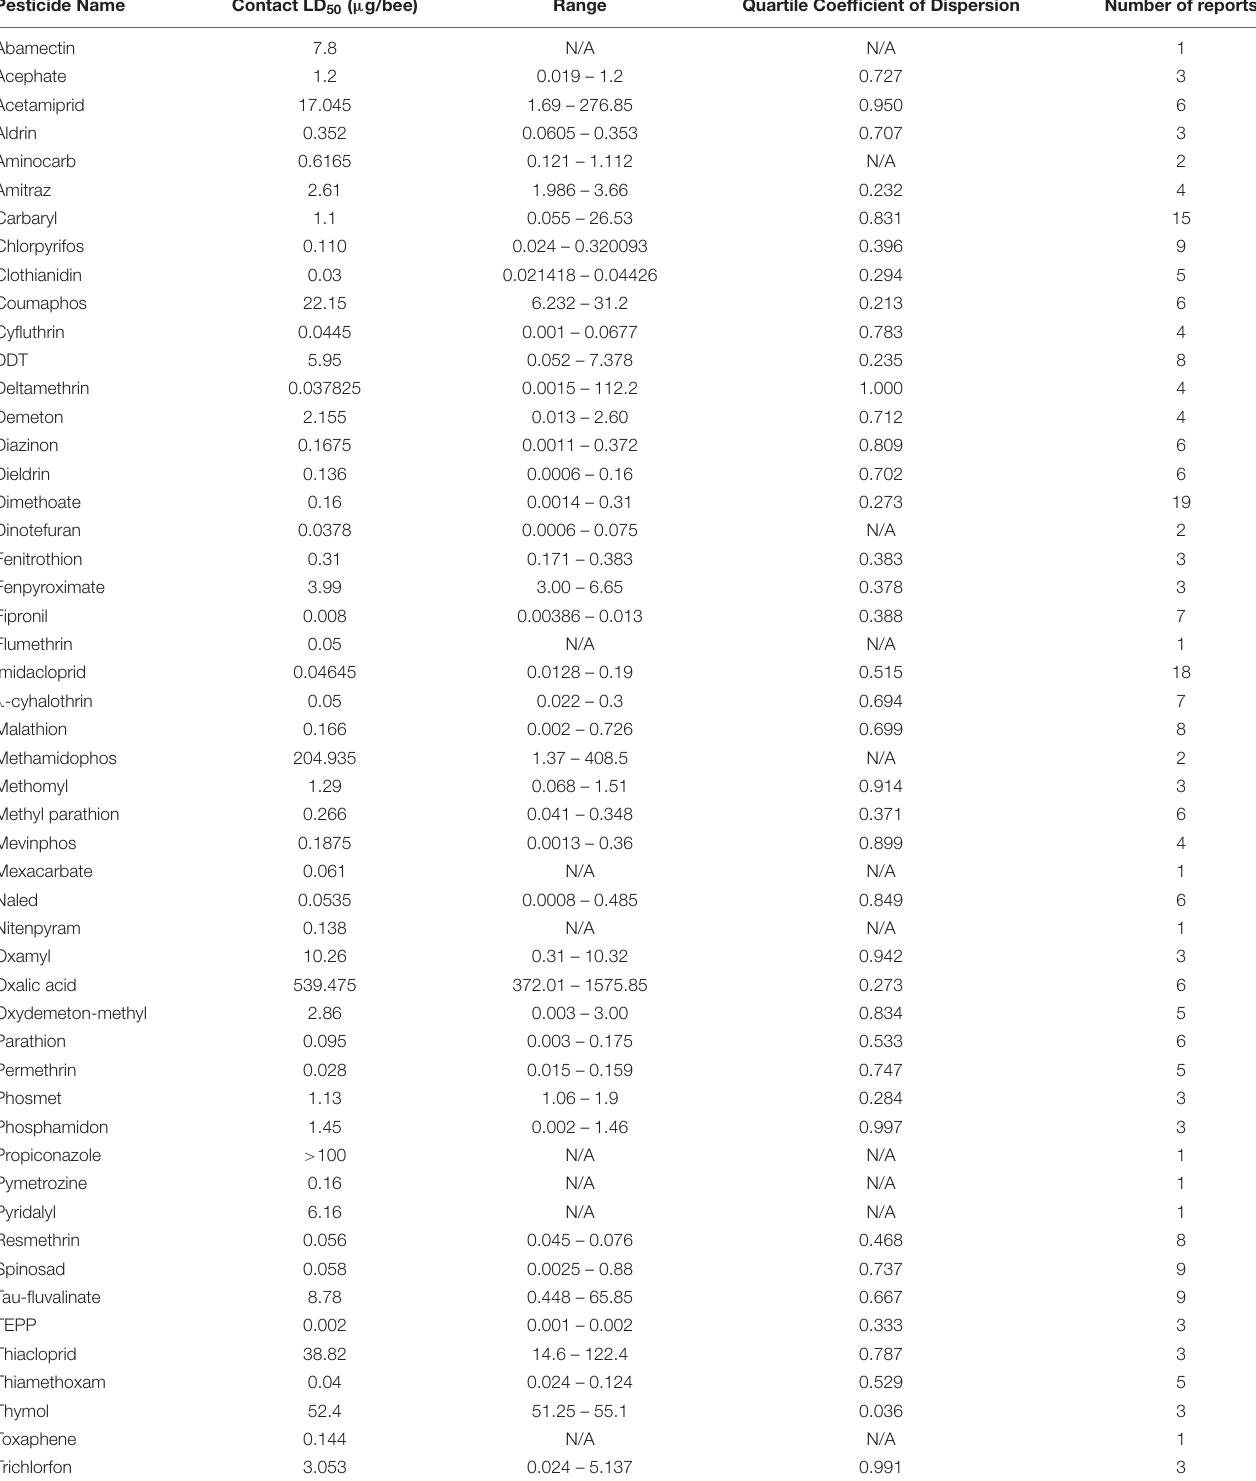
TABLE 1 | Range and median of reported contact LD 50 values of pesticides for adult honey